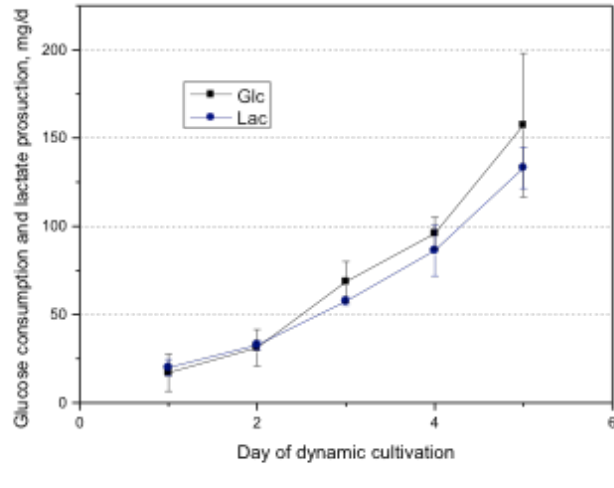
Figure 7. Total glucose consumption and lactate production of UC-MSC cultured in the Z ® RP 2000 H bioreactor. Glucose consumption indicates cell proliferation throughout the cultivation